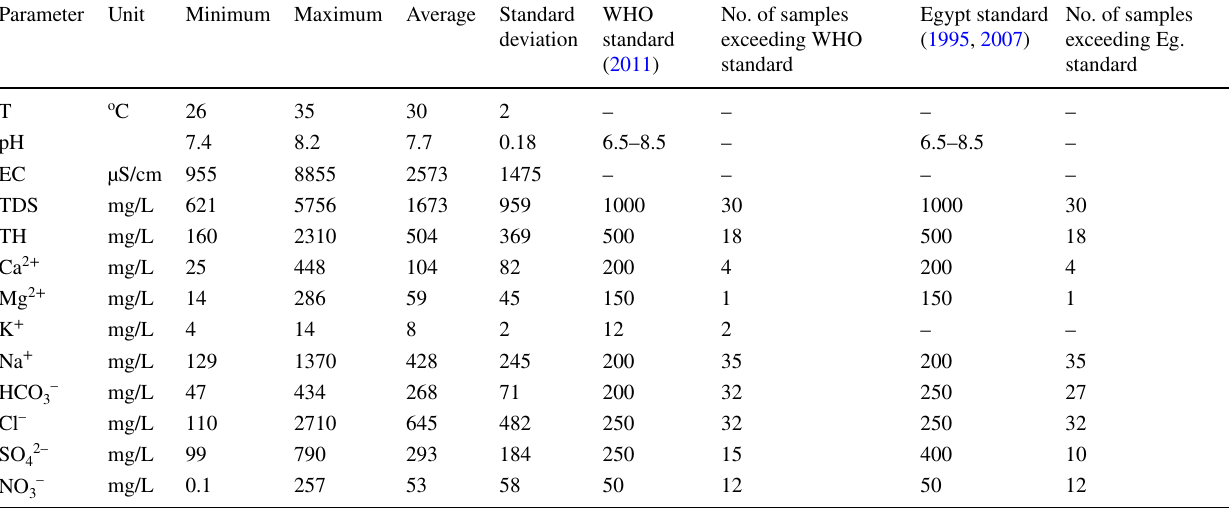
Table 3 Statistical summary of hydrochemical parameters analyzed in groundwater samples in the study area Parameter